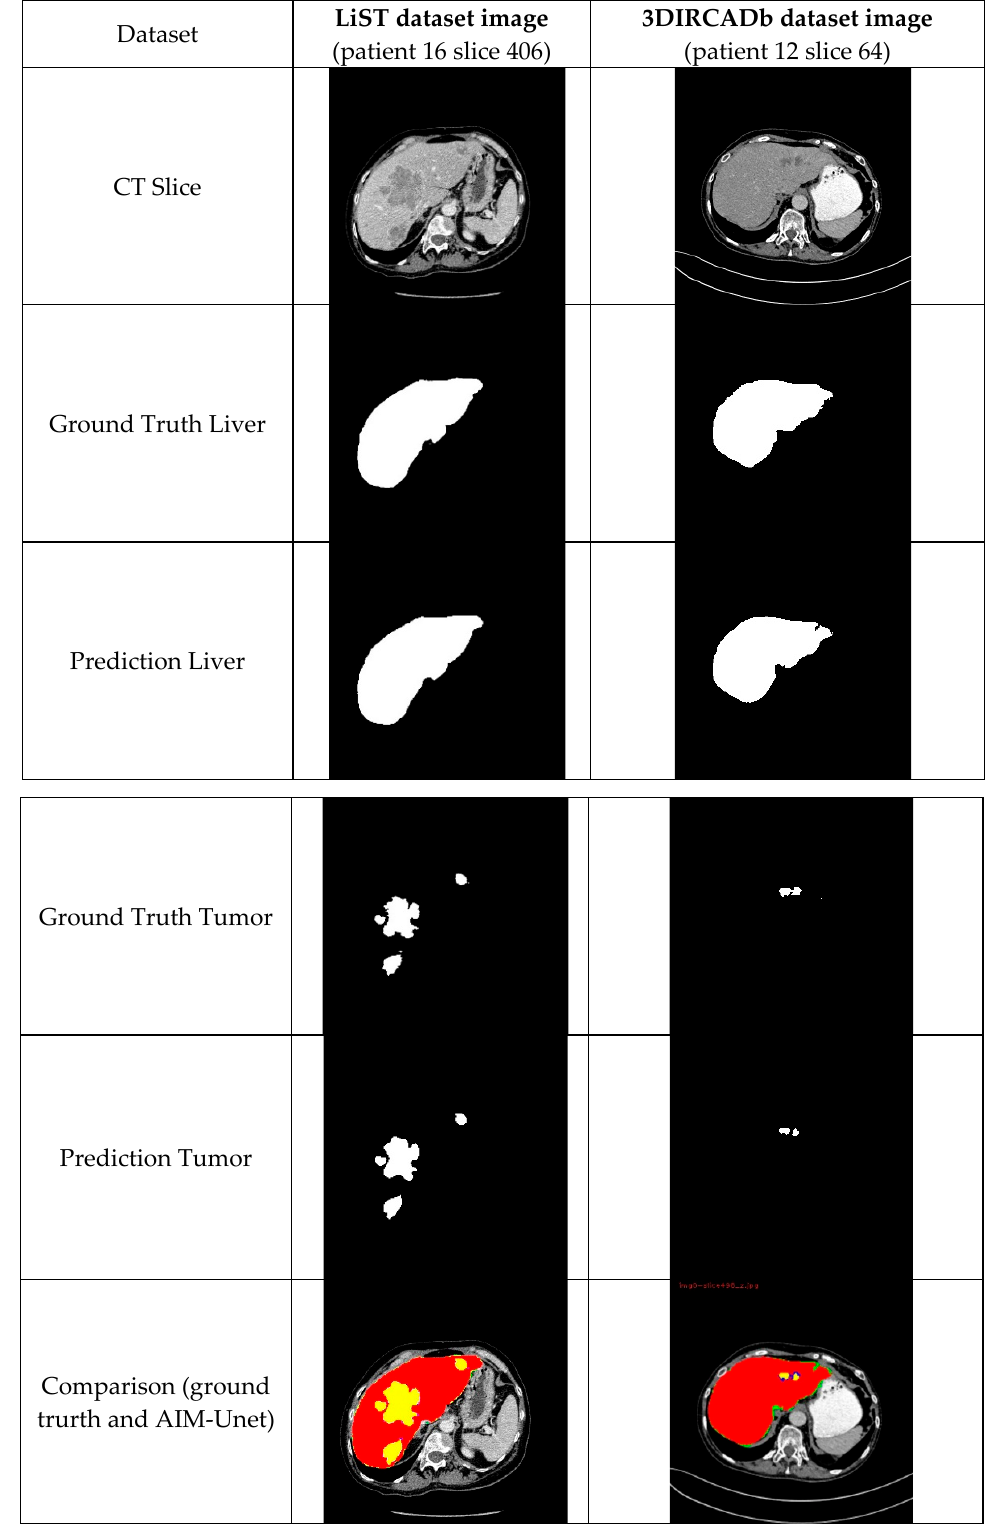
Figure 9. Performance of the proposed model (AIM-Unet) on images of datasets. The green areas in the comparison image show the regions that our model missed for the liver area, the blue areas are the regions that the model missed for the tumor area. The red areas show the region where our model correctly predicted the liver, and the yellow areas show the tumor areas that our model predicted